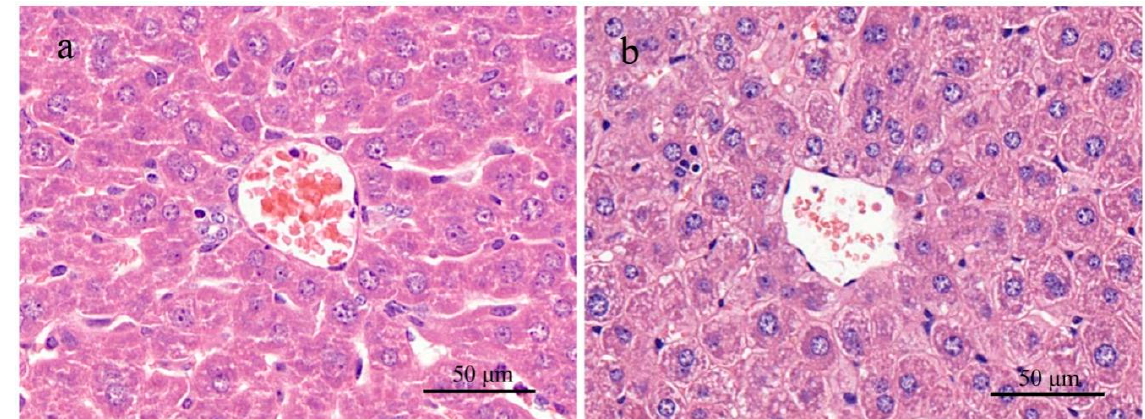
Figure 6. H & E stained histological sections of the livers of mice exposed to MC-RR at concentrations of 0.0 μ g/kg ( a ) and 140.0 μ g/kg ( b ) for 28 days.